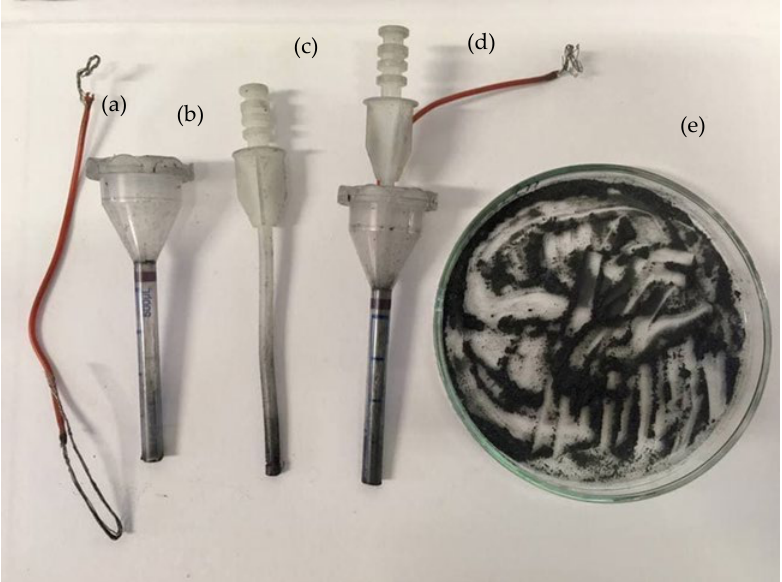
Figure 1. Structure of the CPE ( a ) copper wire, ( b ) polypropylene tube, ( c ) syringe pluger, ( d ) complete CPE, ( e ) paste/oil mix.